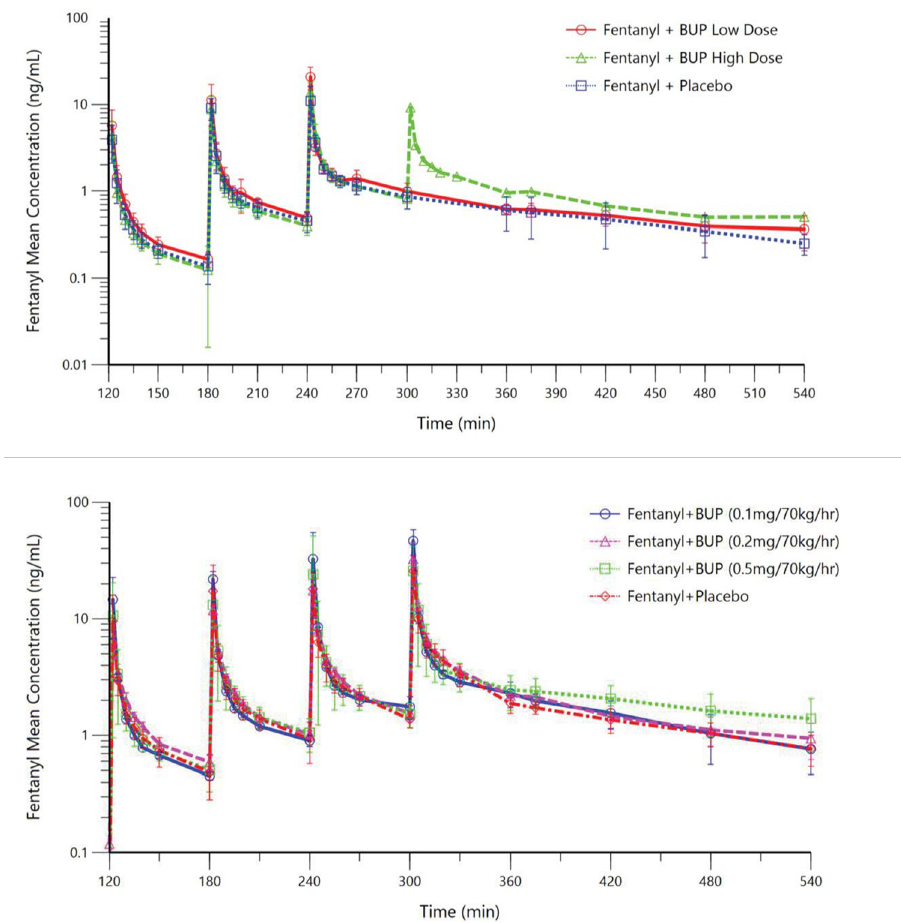
Fig 3. Mean fentanyl plasma concentration-time curves. Upper panel: Part A, healthy volunteers; Lower panel: Part B, opioid-tolerant patients. At 120, 180, 240, and 300 minutes after the start of the buprenorphine or placebo infusion, escalating intravenous fentanyl doses were administered over 90 seconds. Planned fentanyl bolus doses are labelled in the graphs. Higher doses were not administered to participants if they did not tolerate lower fentanyl doses.